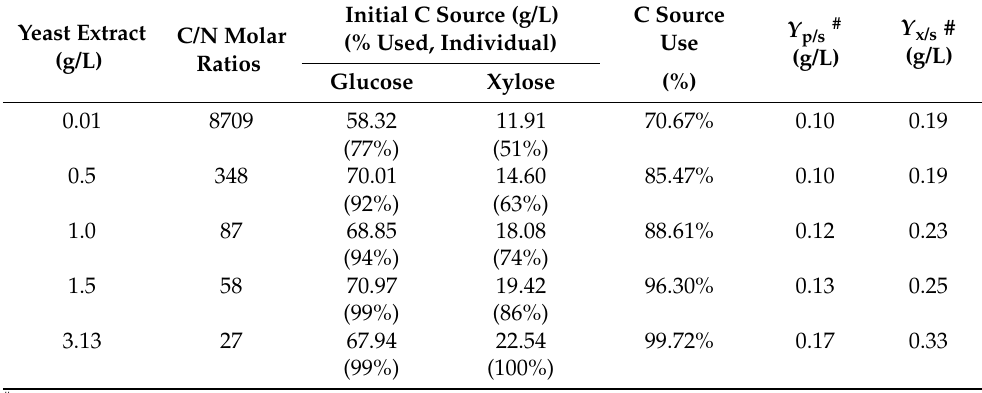
Table 6. Carbon source use, lipid yield and cell yield when cultivating R. glutinis TISTR 5159 for a maximum of 10 days in the bagasse hydrolysate with C/N molar ratio adjusted by adding yeast extract.